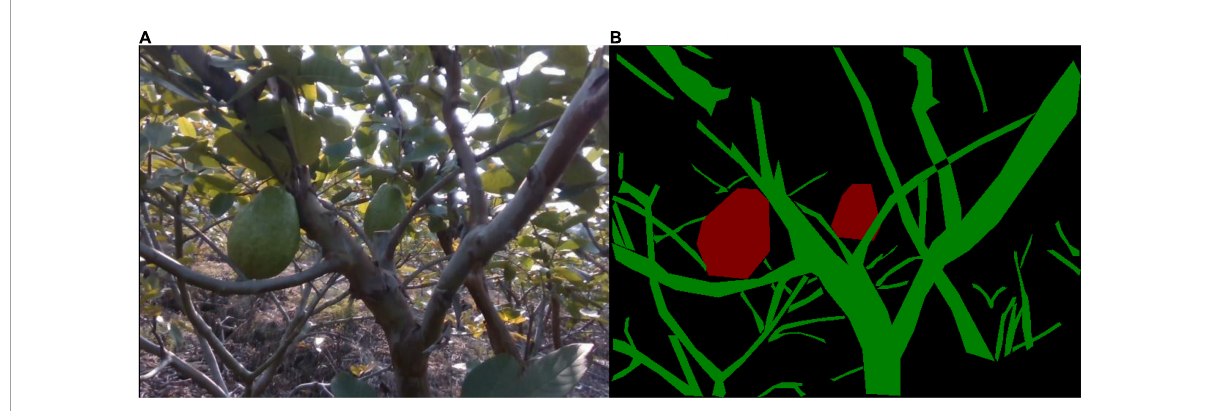
FIGURE1 Image example. (A) A guava tree. (B) Different parts of the guava tree, where the red, green, and black regions represent the fruit, branch, and background,